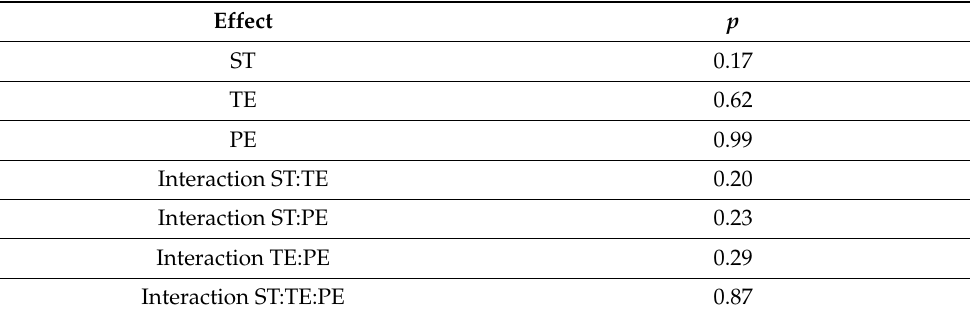
Table 3. Three-way ANOVA results of track density *.